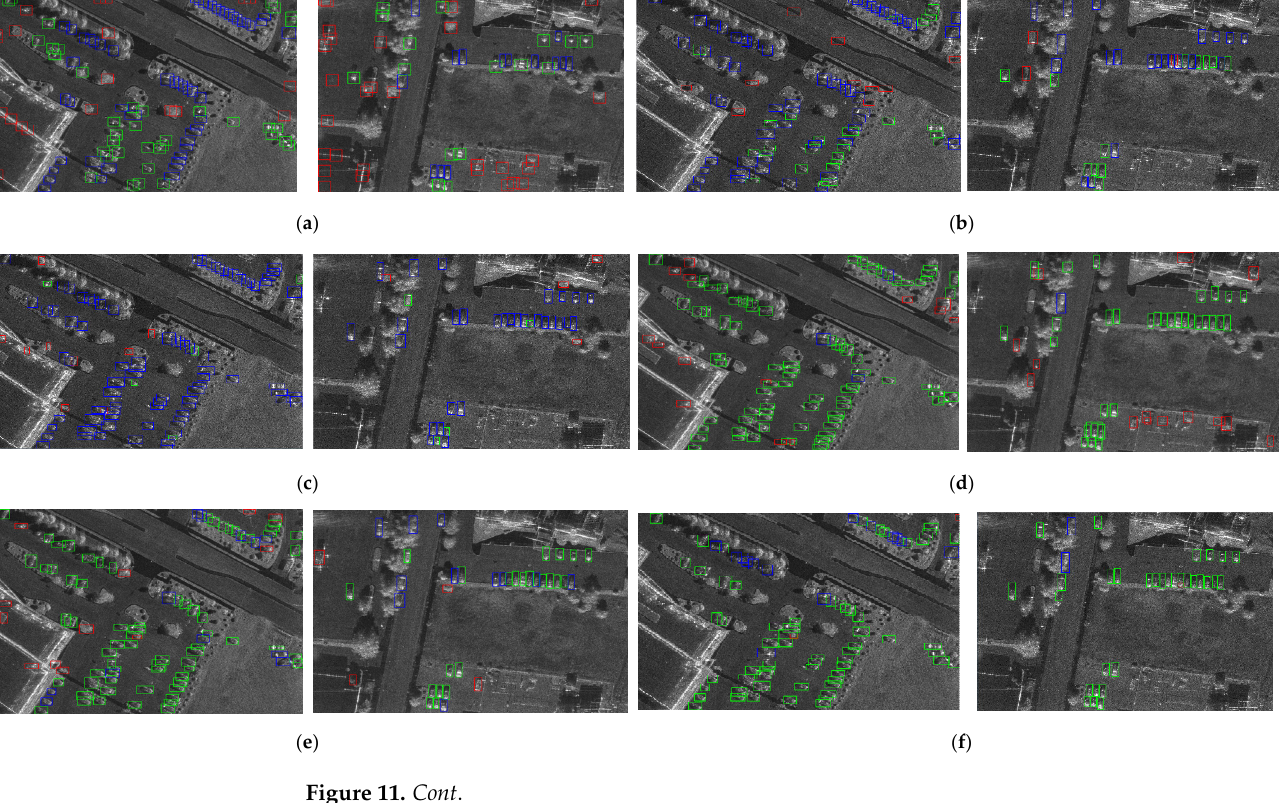
( j ) ( k ) Figure 11. The target detection results of different methods for the two test images in the FARAD- SAR dataset, where the green, red, and blue rectangles indicate the correctly detected cars, the false cars, and the missing cars, respectively. ( a ) Gaussian-CFAR. ( b ) DAF. ( c ) HTCN. ( d ) Faster R-CNN. ( e )